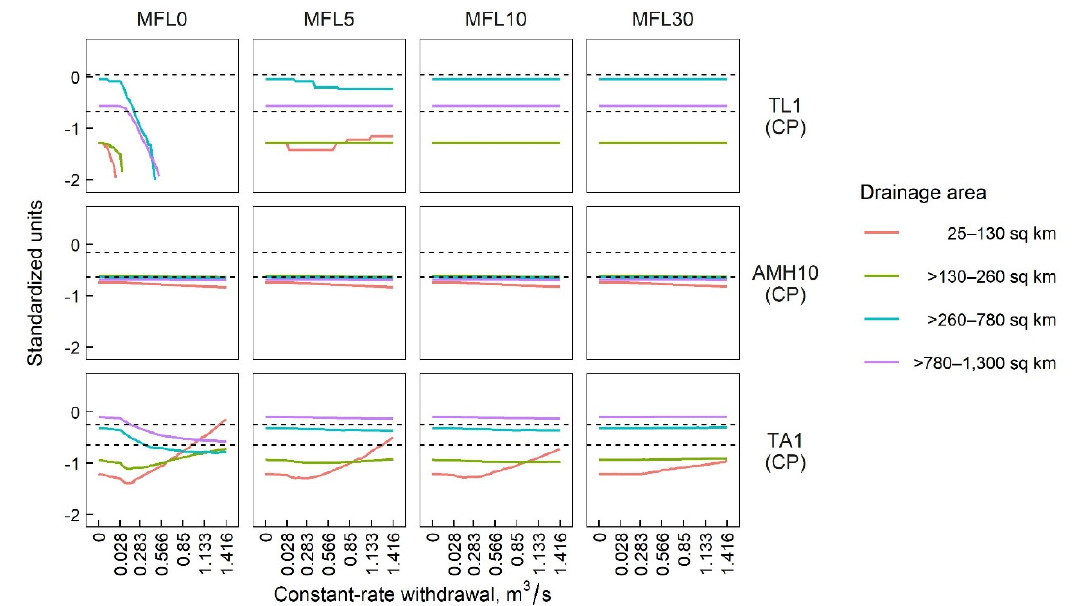
Figure 4. Mean responses of select streamflow characteristics (SFCs) to incremental constant-rate withdrawal scenarios and minimum flow levels (MFL) within the Cumberland Plateau (CP). Solid lines represent the mean SFC response across sites for each drainage-area size; horizontal dashed lines are the interquartile range (IQR) of SFCs from reference sites within each ecoregion [38,39,41].